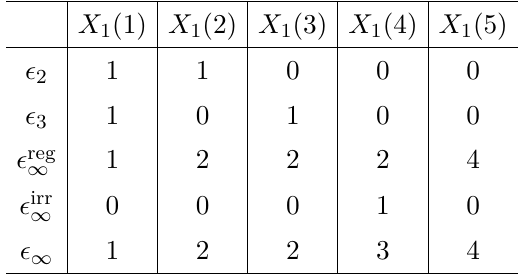
Table 18 . The numbers (cid:15) 2 , (cid:15) 3 of elliptic points of order 2 , 3 and the number (cid:15) ∞ of cusps for the modular curves X ( N ) with N = 1 , . . . , 5 1